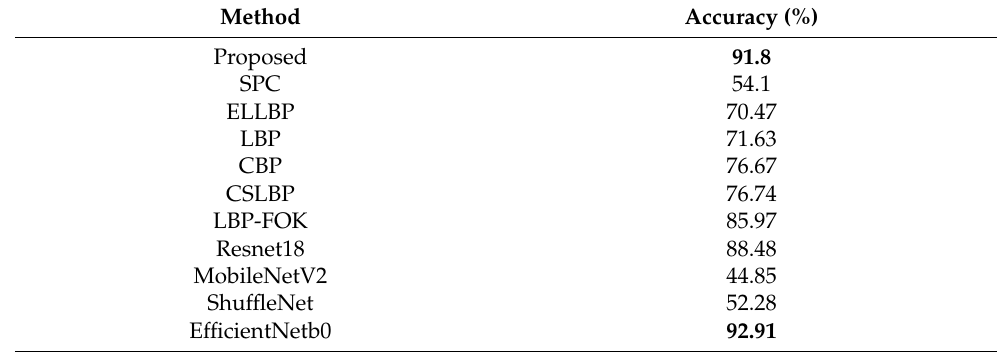
Table 14. Direct comparison of the proposed method to other methods. Bold values signify the best